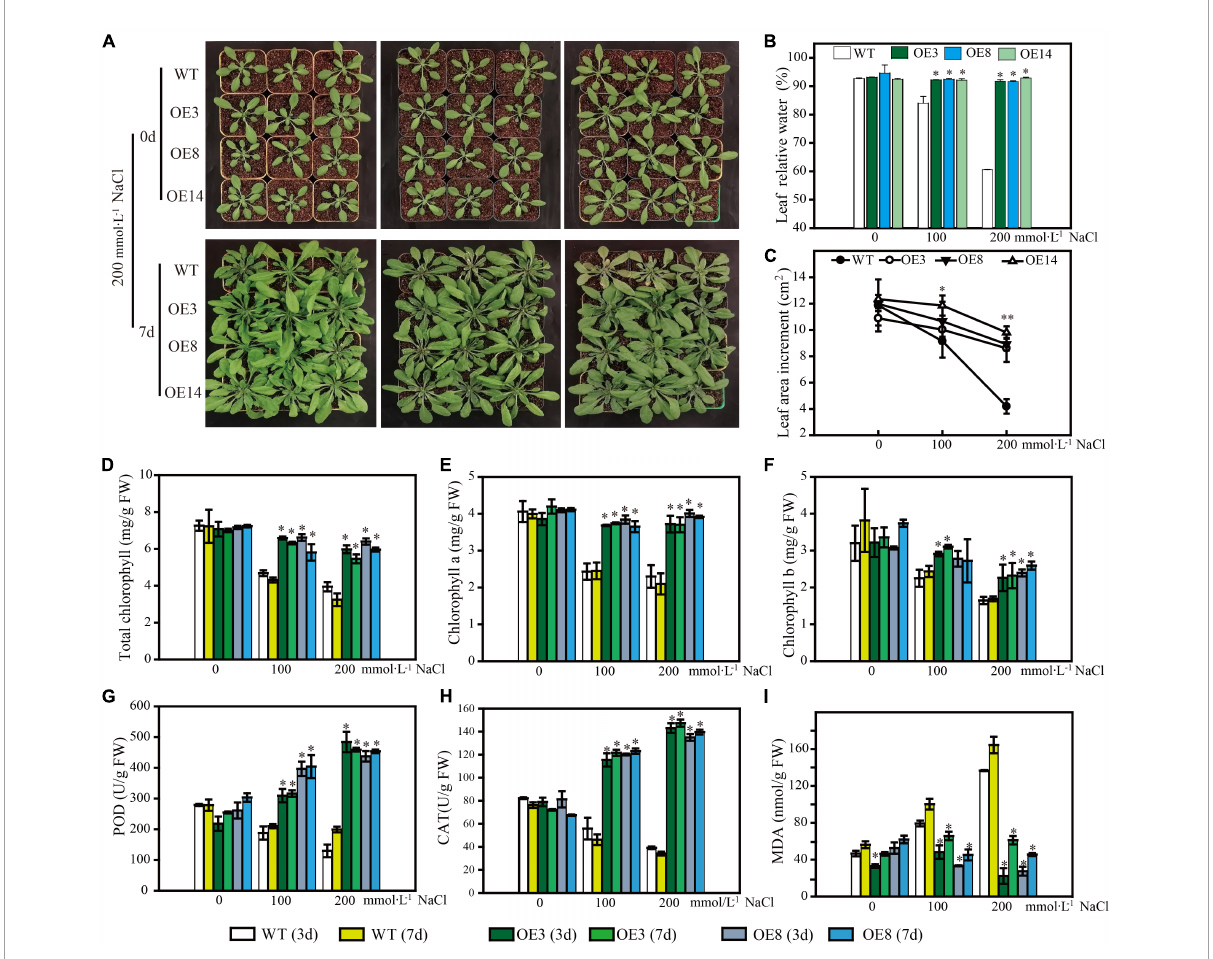
FIGURE8 Phenotype of LiSOS2 OE lines. (A) Phenotype of plants before and after salt stress. (B) Relative water contents of leaves. (C) Leaves area increment per plant after salt treatment. (D) Total content of chlorophyll. (E) Chlorophyll a. (F) Chlorophyll b. (G) Activity of POD. (H) Activity of CAT. (I) Content of MAD. Mean ± SD, n ≥ 3, ∗ p < 0.05, ∗∗ p < 0.01 (Student’s t- test, compared to the WT at same